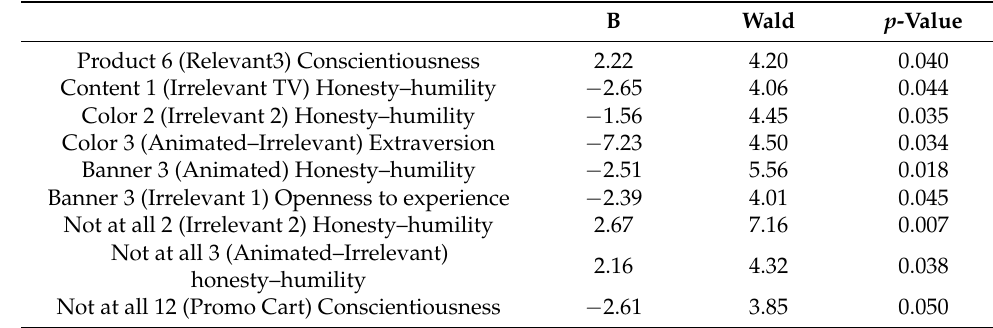
Table 3. Correlations between personality traits and recognition